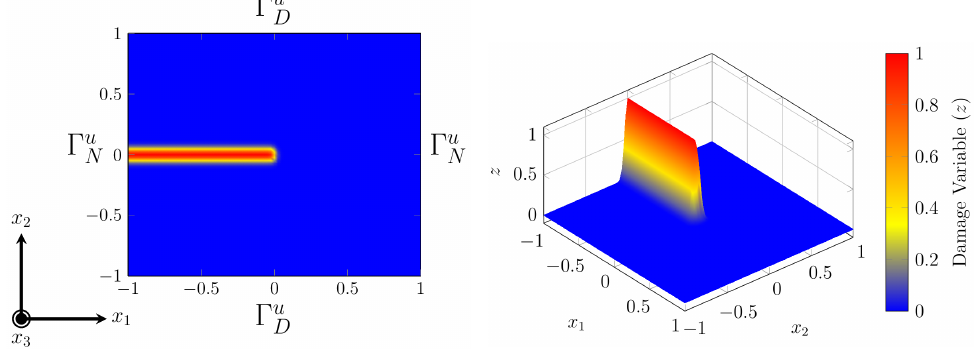
Figure 8. Illustration of the phase field approximation of the cracked surface in an elastic body. The symbol ( ) + on the right-hand side in (22b) denoted the positive part ( s ) + : = max ( s , 0 ) , and it represents the irreversible property of crack